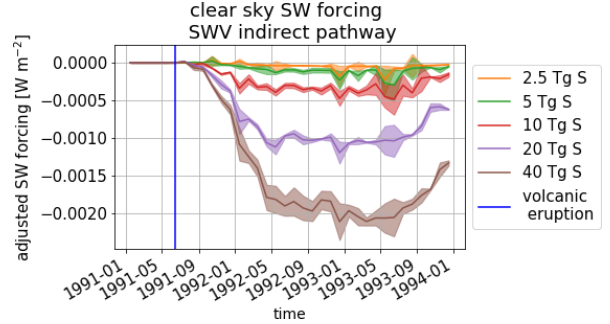
Figure E1. Time evolution of the SW component to the adjusted clear-sky forcing in the tropical region at [− 5 , 5 ] ◦ latitude for the ensemble mean SWV increases caused by all eruption strengths. The blue line marks the eruption time. The flux range originating from the standard deviations of the SWV profiles is plotted to visu- alize the signal